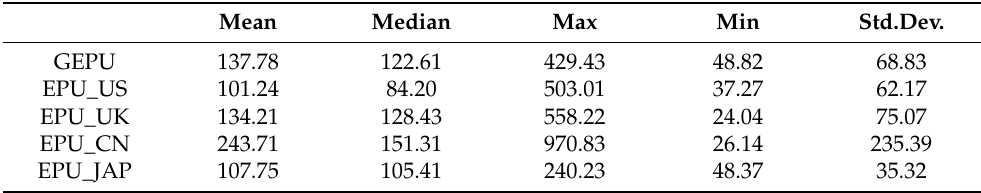
Table 6. Descriptive statistics of EPU indexes in selected countries.